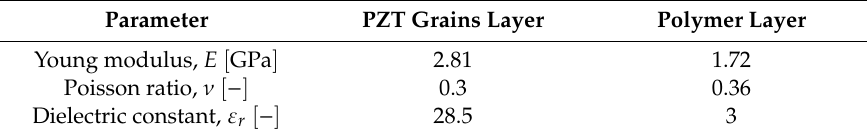
Table 1. Material parameters of the composite